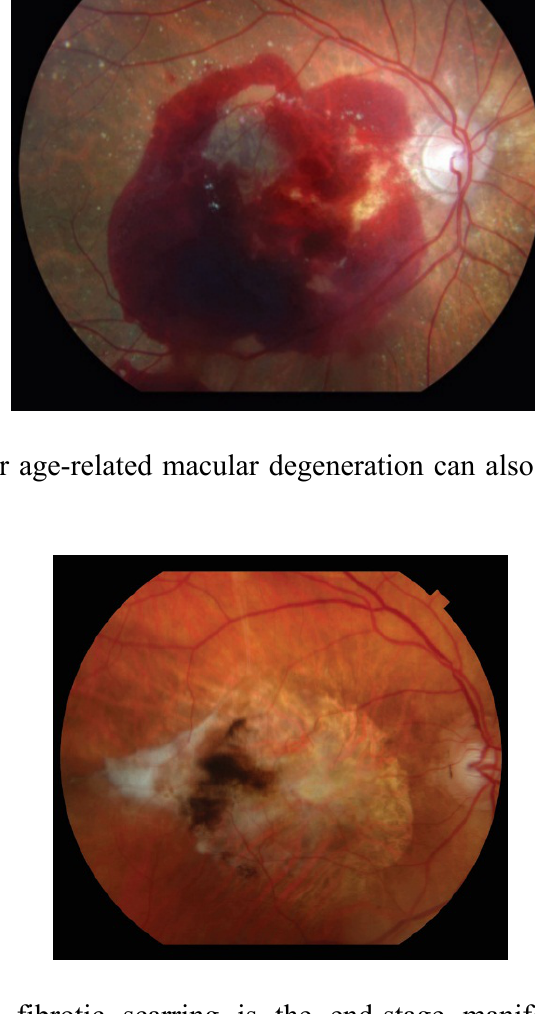
Figure 5. Subretinal fibrotic scarring is the end-stage manifestation of neovascular age-related macular